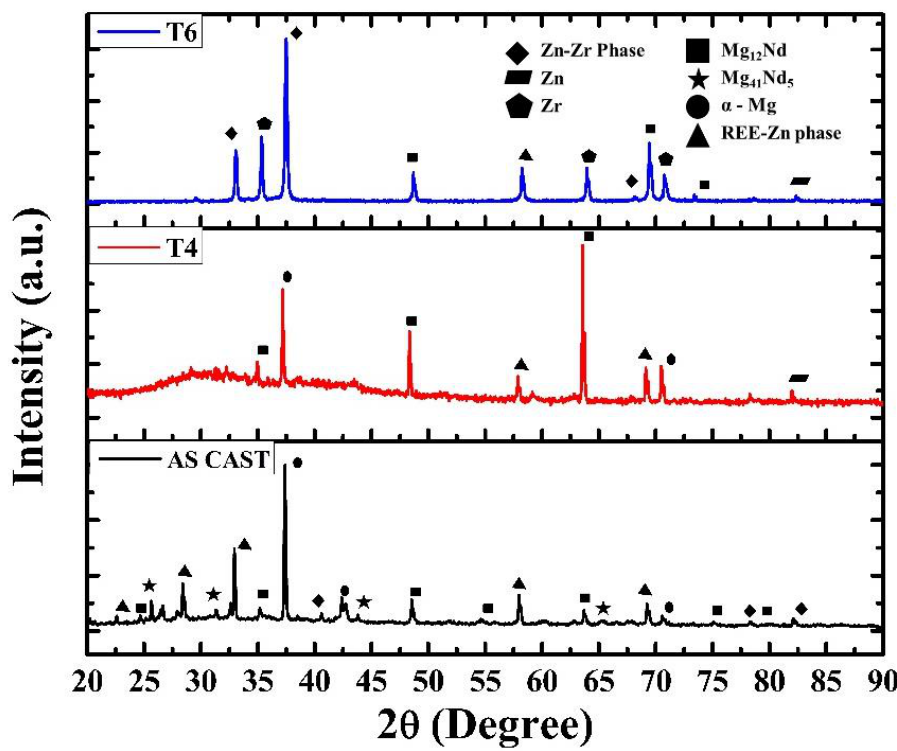
Figure 2. XRD patterns of EV31A in as-cast (black); T4 (red); T6 (blue) conditions.